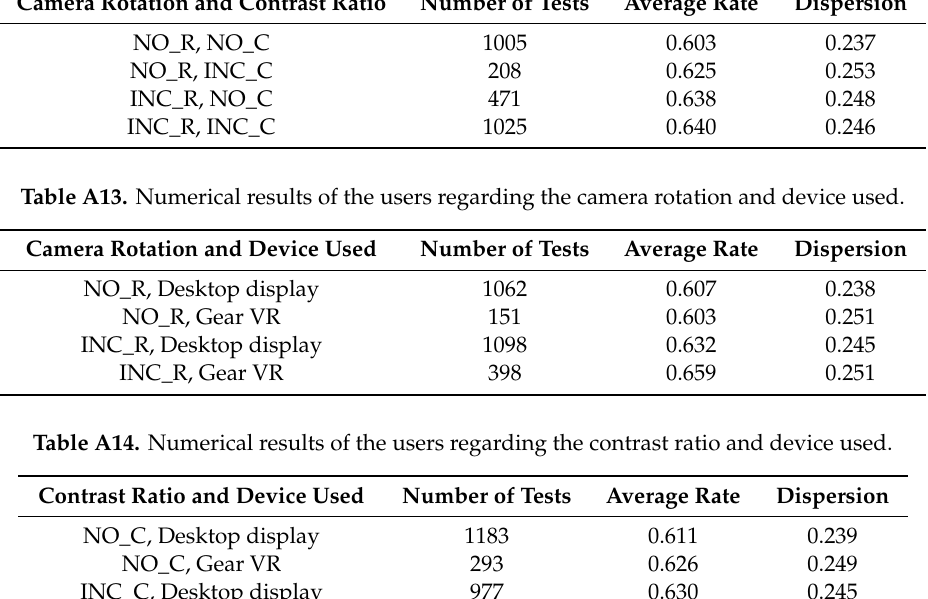
Table A12. Numerical results of the users regarding the camera rotation and contrast ratio. Camera Rotation and Contrast Ratio